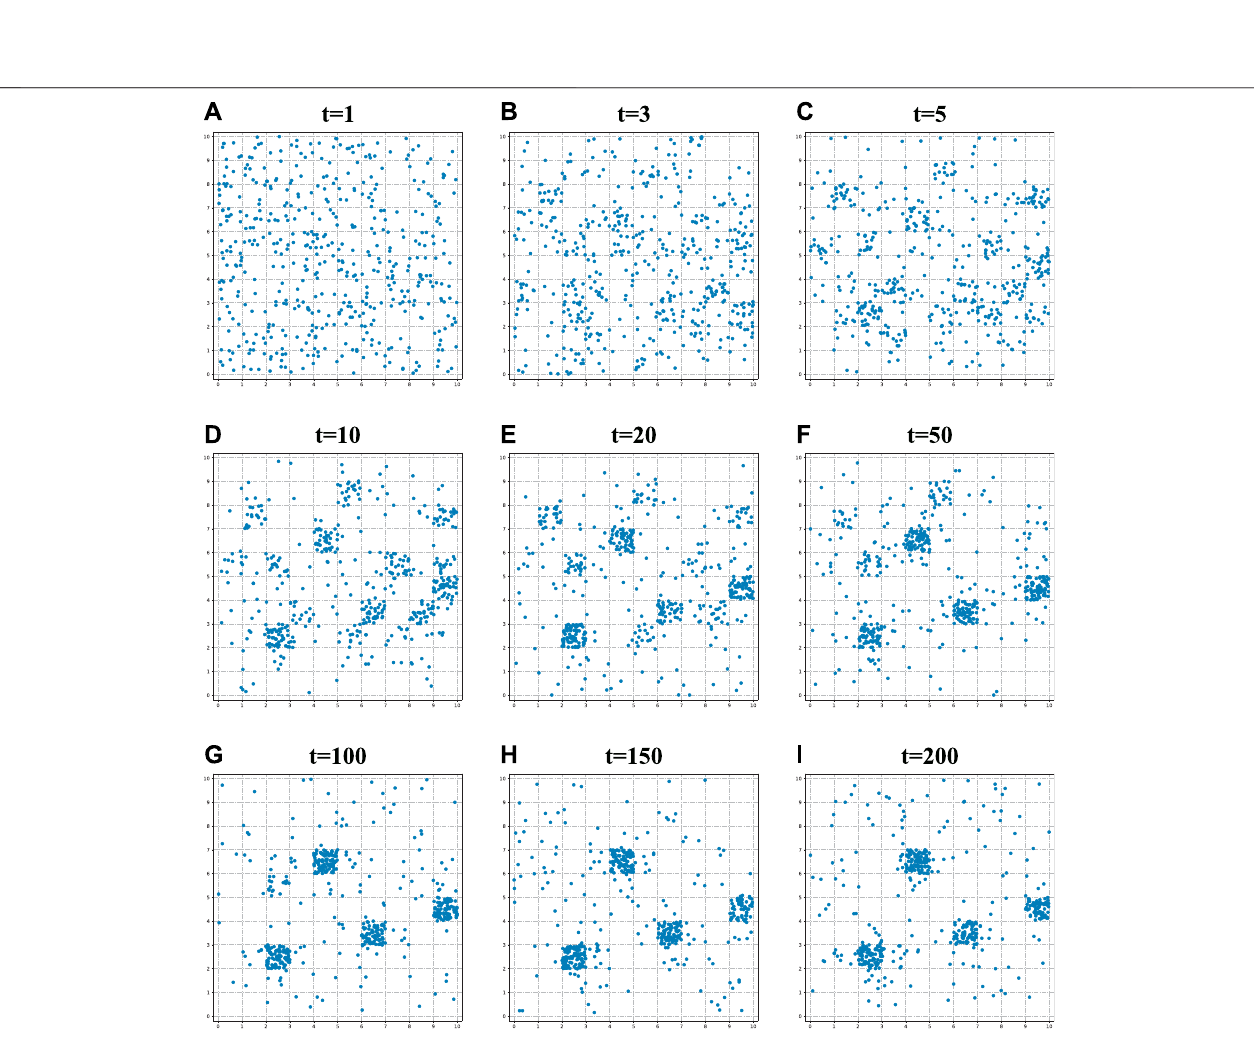
Frontiers in Physics |